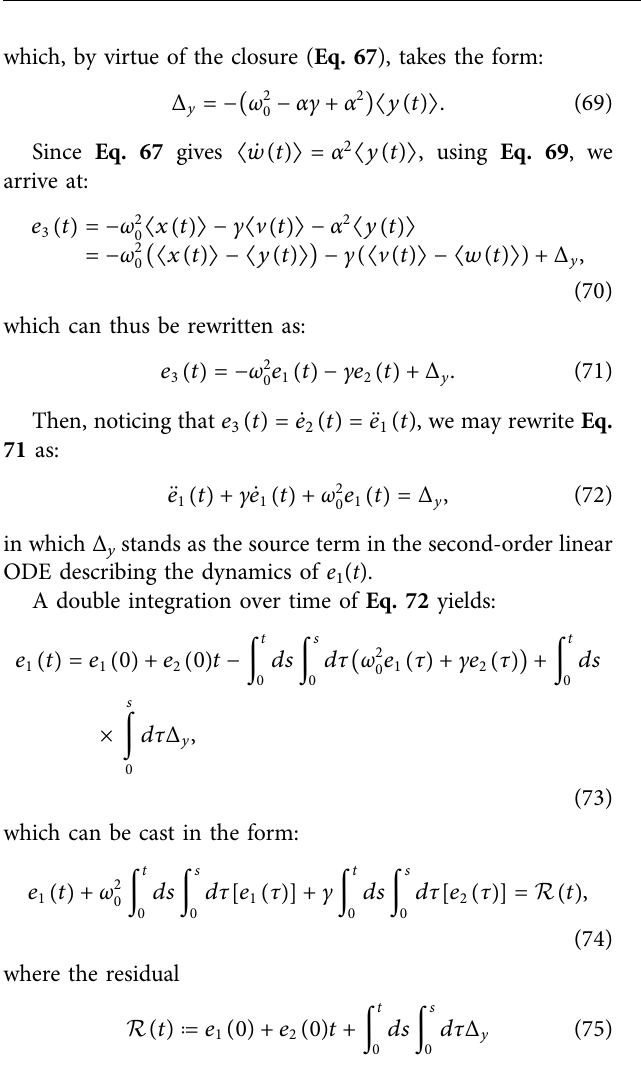
FIGURE2| SolutionsoftheODE( Eq.72 ),with x =2, v = − 1, y =1andwithdifferentchoicesoftheclosure( Eq.67 ).Shown arethereduction errorscorresponding to the fi rst-order term of the Chapman-Enskog expansion (dotted curve), the corresponding third-order approximation of the same expansion (dashed curve) and the solution of the invariance equation (solid curve). The values of ω 0 and γ s in the various panels correspond to those considered in Figure 1